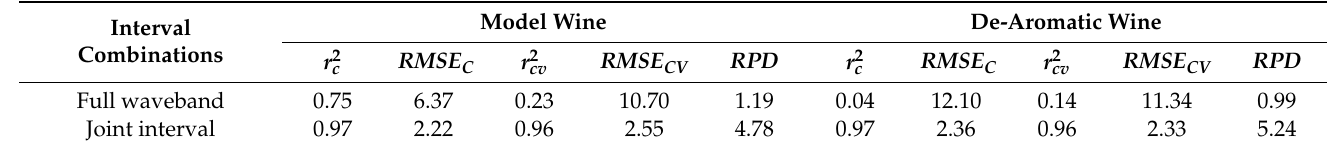
Table 5. Results of full-band and joint interval modeling of model wine and de-aromatic wine.